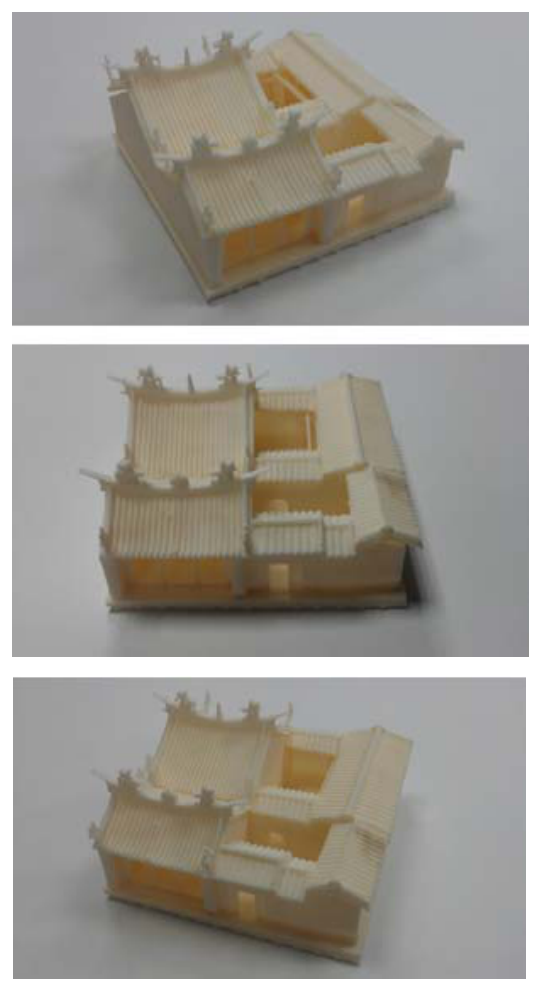
Figure 17. Exterior of Taipei Xia Hai City God Temple(RP)